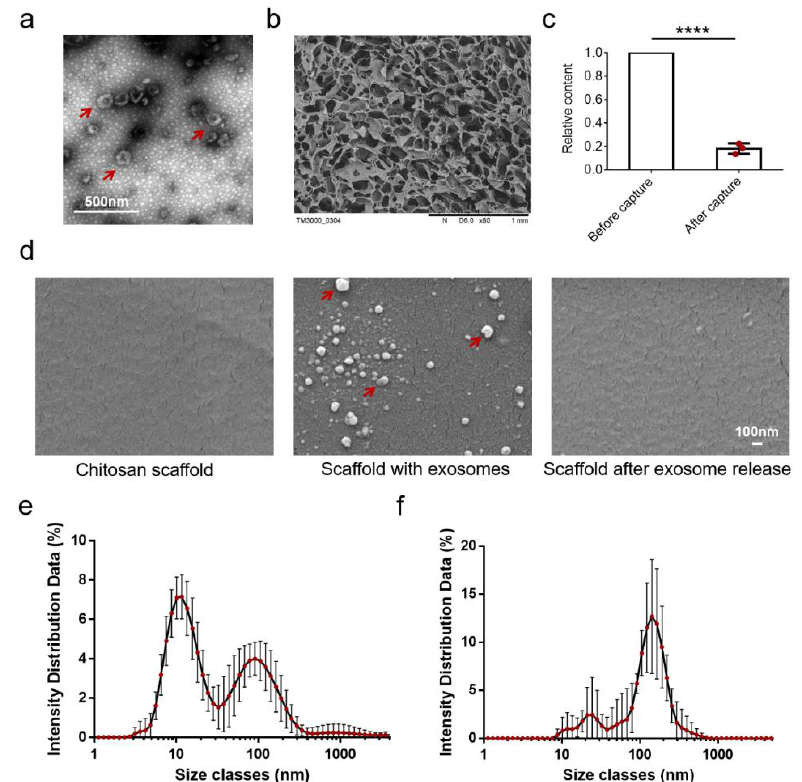
Figure 2. Performance of the exosome separation device. ( a ) TEM images of the structure of standard exosome samples obtained by ultracentrifugation. The red arrows indicate exosomes. ( b ) SEM images of the structure of the chitosan scaffold. ( c ) The relative content of exosomes before and after being separated by the exosome separation device. The results were normalized to the original concentration. The data were presented as the mean ± SD, n = 3. **** p < 0.0001 by two-sided paired Student’s t -test. ( d ) SEM images of the surface of the chitosan scaffold before exosome capture, after exosome capture, and after exosome release. The red arrows indicate exosomes absorbed on the scaffolds. ( e ) Particle size analysis of pretreated cell culture medium samples. The data were presented as mean ± SD, n = 3. ( f ) Particle size distribution of exosomes after being isolated by the exosome separation device. The data are presented as the mean ± SD, n =